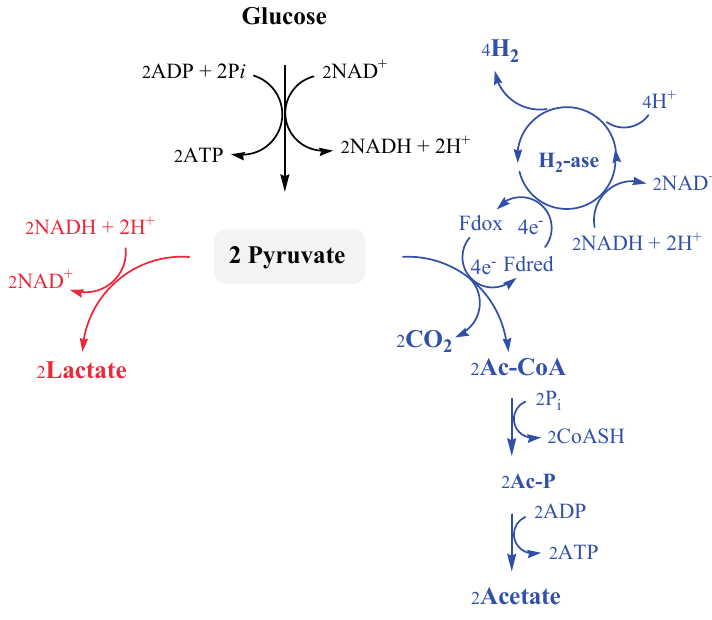
Figure 1. Streamlined biochemical pathway for fermentative H 2 production, adapted from Reference [22]. Water is omitted for